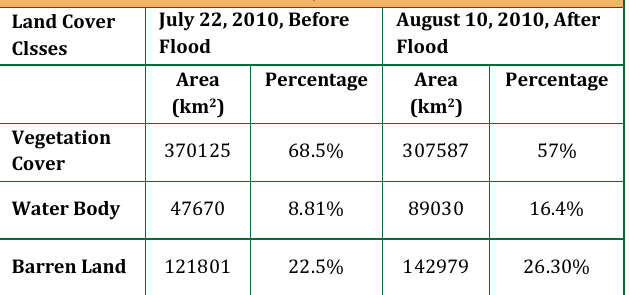
Table 1: Represents land covers distribution for each class before and after the 2010 flood occurred in the flood plain zone of district Charsadda,